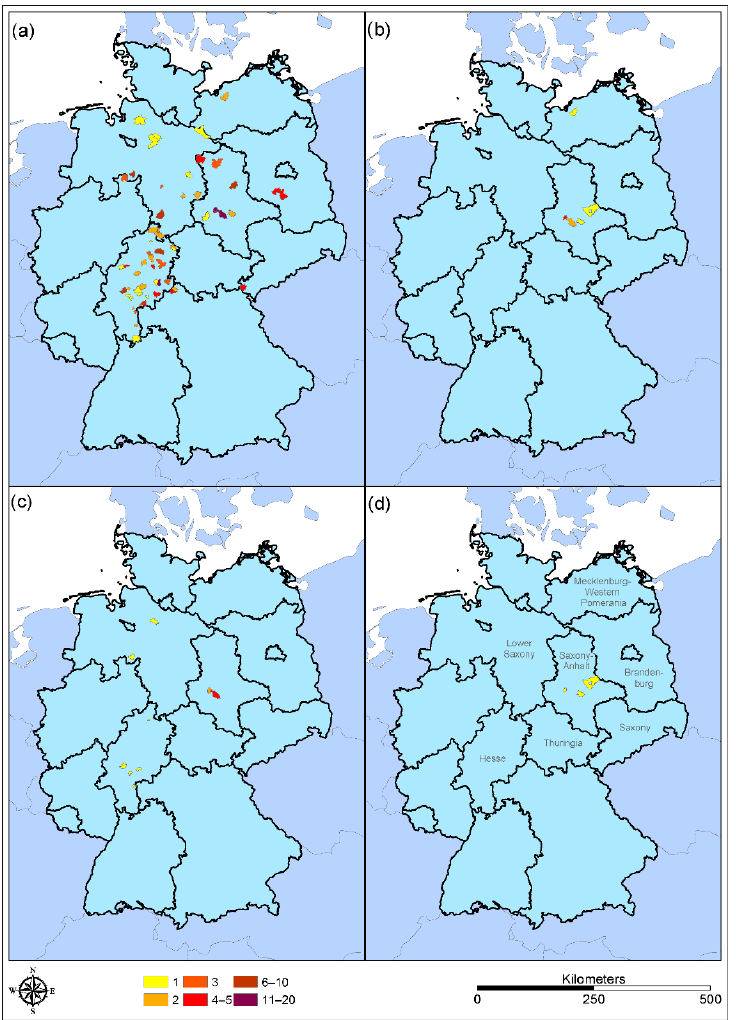
Figure 2. Origin and number of tested samples. ( a ) Sampling raccoon ( Procyon lotor ), ( b ) sampling raccoon dog ( Nyctereutes procyonoides ), ( c ) flavivirus-positive tested raccoon samples ( Procyon lotor ), ( d ) flavivirus-positive tested raccoon dog samples ( Nyctereutes procyonoides ). Number of samples per sampling site are represented by colors, as